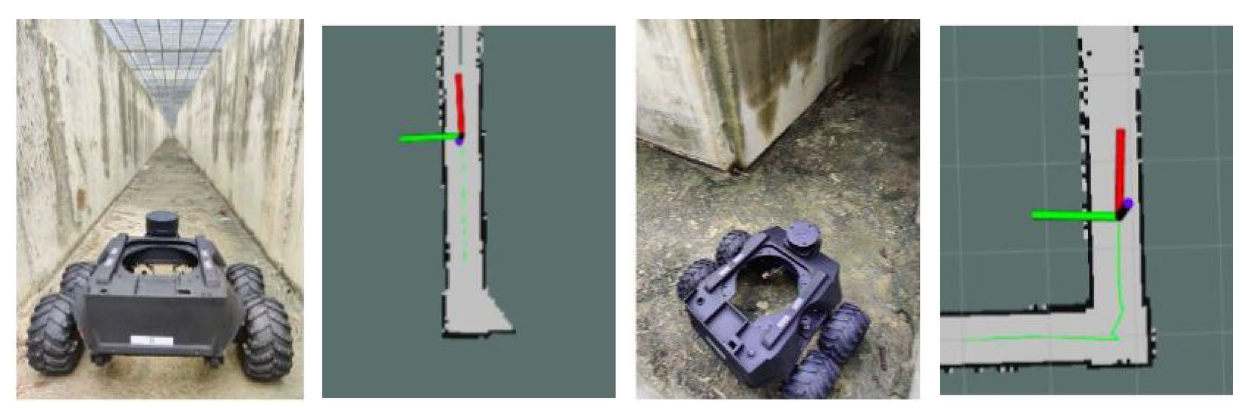
Figure 14. Mapping and path tracking results of